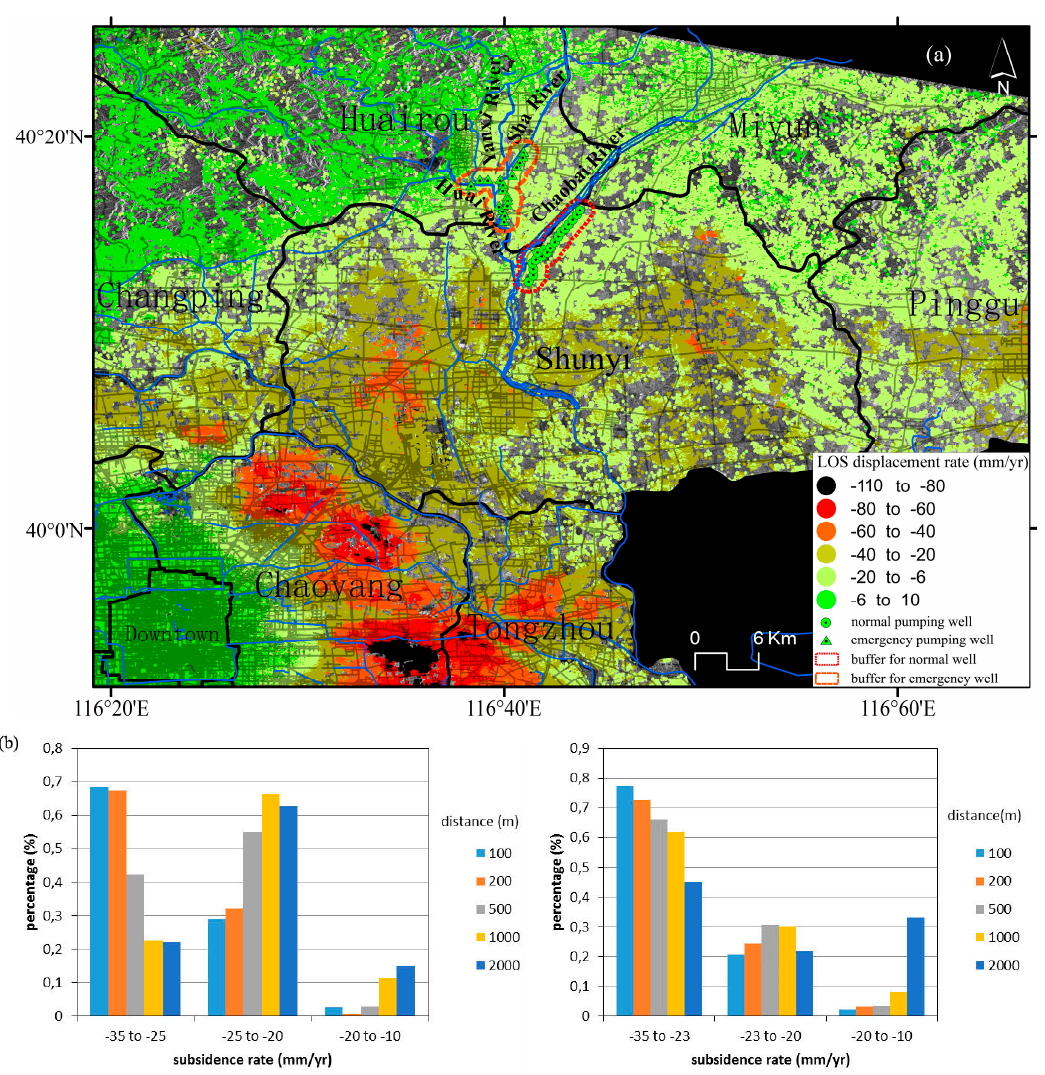
Figure 13. ( a ) Location of the Huairou emergency wells and the well field located along the Chaobai River overlapped to the InSAR subsidence rate map; ( b ) Statistics of InSAR-derived data against the distance to the Chaobai River ( left ) and Huairou ( right ) pumping wells.